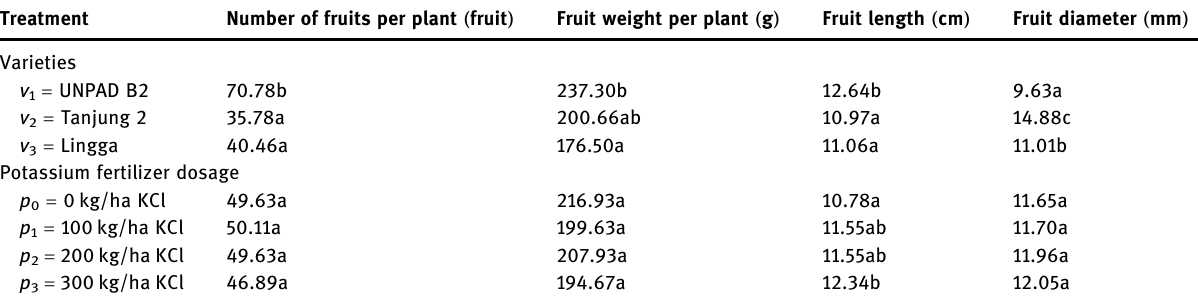
Table 6: E ff ect of potassium fertilizer dosage and varieties on number of fruits per plant, fruit weight per plant, length, and diameter